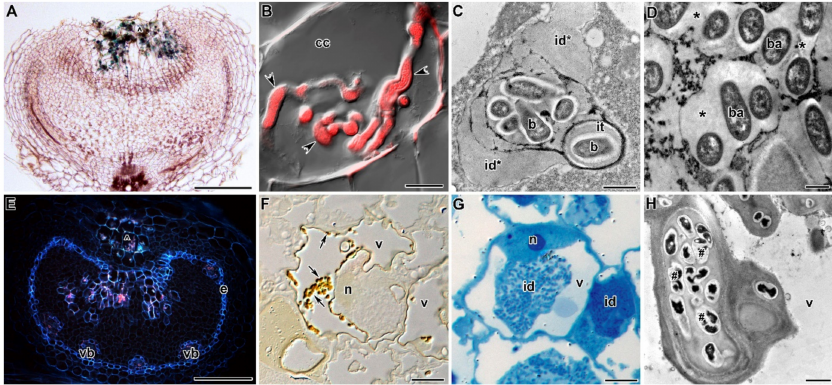
Figure 2. Phenotype of nodules of mutants in the gene PsSym33 2 ( H ) and 4 ( A – G ) weeks after inoculation with Rhizobium leguminosarum bv. viciae strains VF39- gusA [113] ( A ), 3841 [120] ( B – G ), and RCAM1026 [121] ( H ). ( A ) Histological organization of the nodule of mutant SGEFix − -2 ( Pssym33-3 ); the expression pattern of constitutive gusA fusion. ( B ) Highly ramified infection thread in a colonized cell in the nodule of mutant SGEFix − -2 ( Pssym33-3 ); merging of di ff erential interference contrast (DIC) and the red channel (rhizobia). ( C ) Infection thread with bacteria-free infection droplets in the white nodule of mutant SGEFix − -2 ( Pssym33-3 ); TEM. ( D ) “Multiple” symbiosomes with undi ff erentiated